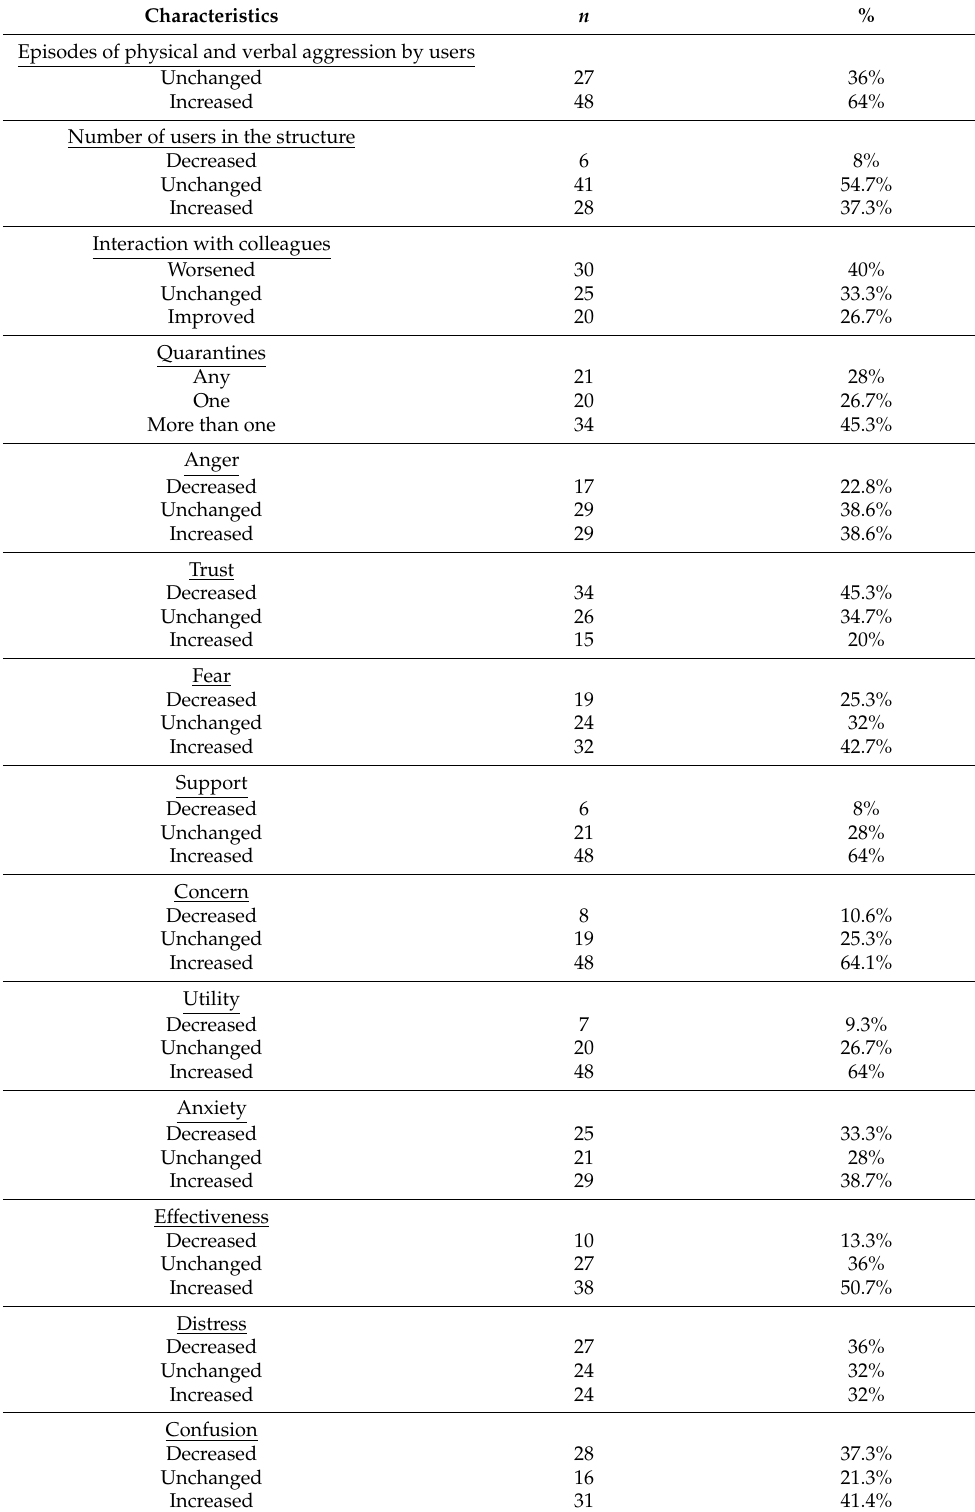
Table 3. COVID-19